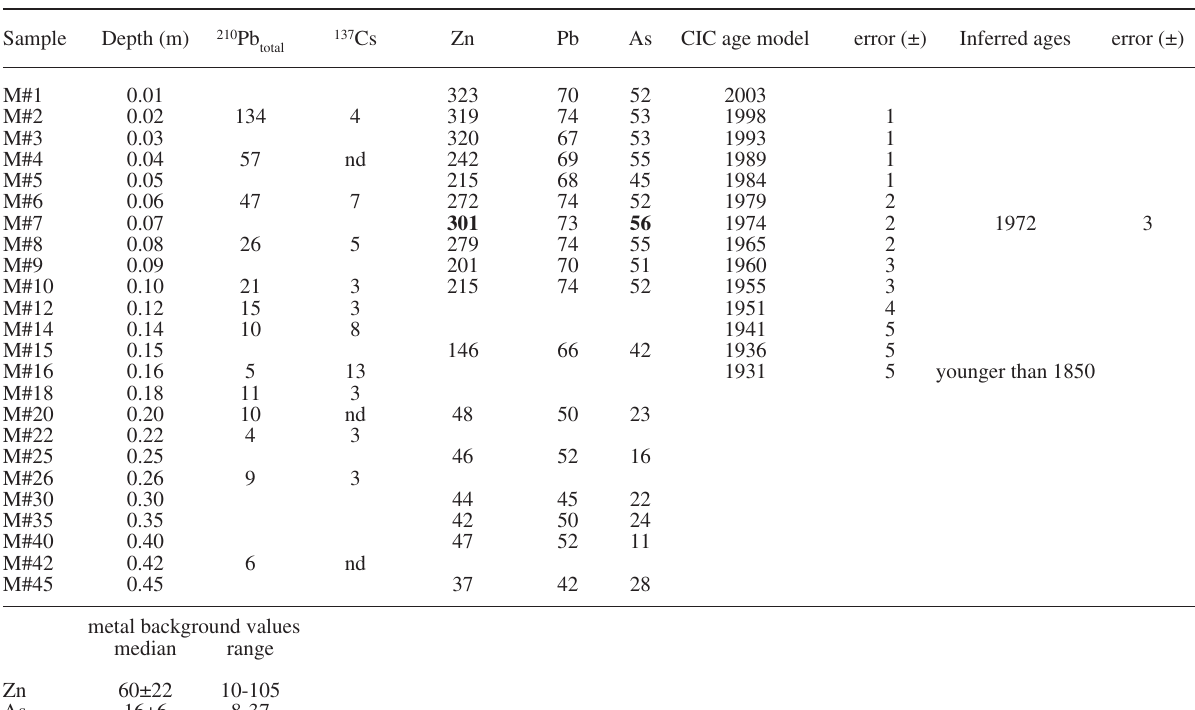
Table 3. – 210 Pb , and 137 Cs content (Bq kg -1 ), metal concentrations and metal background values (mg kg -1 ) in the muskiz core. metal total background values were calculated for the Basque estuaries by Cearreta et al . (2000). CiC age model with assigned errors and metal